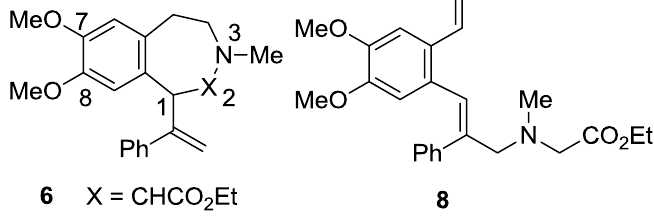
Figure 1. Proposed structures for the benzazepine 6 and ring-opened compound 8